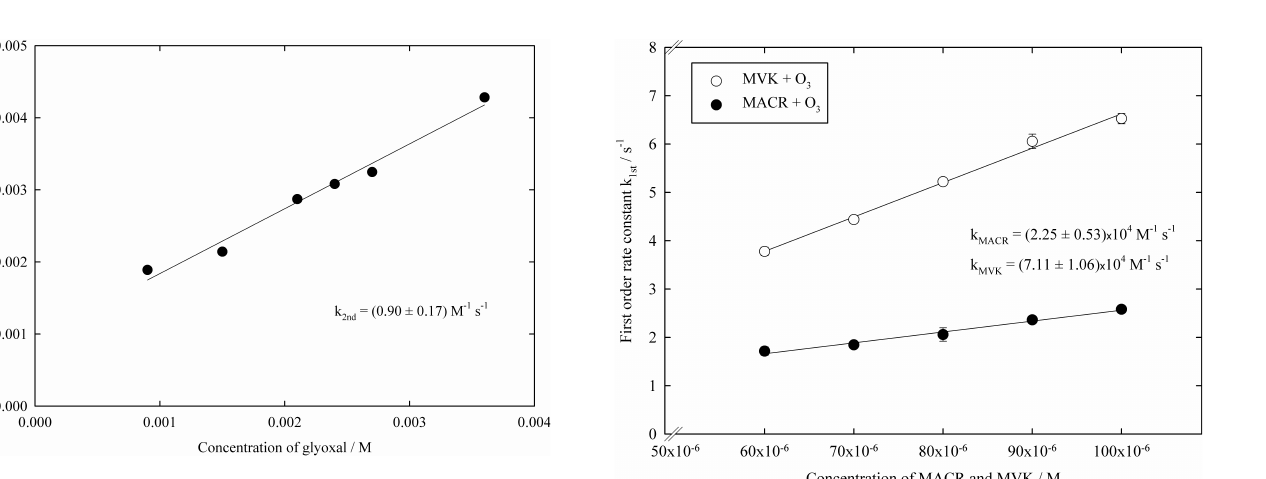
2 Fig. 3. Pseudo-first order rate constants k 1st plotted over the con- 3 Fig. 4. Pseudo-first order rate constants k centration of glyoxal during the reaction with ozone at pH 5. The initial concentration of ozone was about c(O 3 )=3 × 10 − 5 M. The centration of methacrolein and methyl vinyl ketone for the reaction slope corresponds to k glyoxal + O =(0.90 ± 0.17)M − 1 s − 1 . with ozone at pH 2. The initial concentration of ozone was about 3 c(O 3 )=6 × 10 − 6